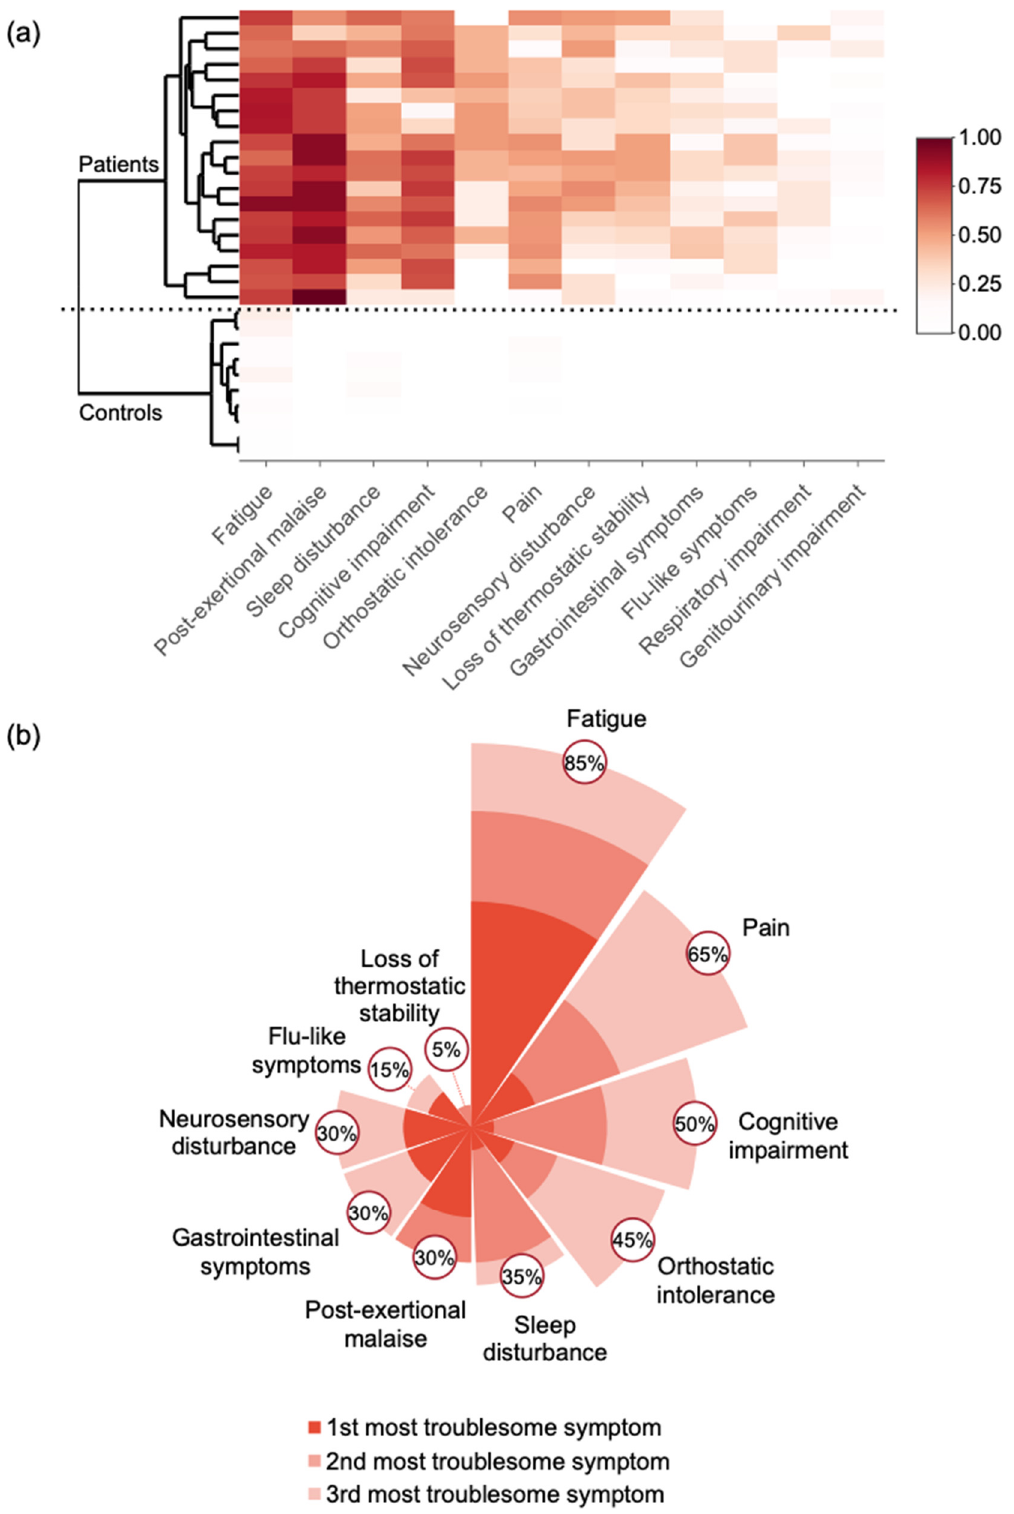
Figure 2. Common Symptoms in Severe ME/CFS Patients. ( a ) Similarity and variation of the symptoms of the SIPS patients and ( b ) the top three most troublesome symptoms of the SIPS Patients.